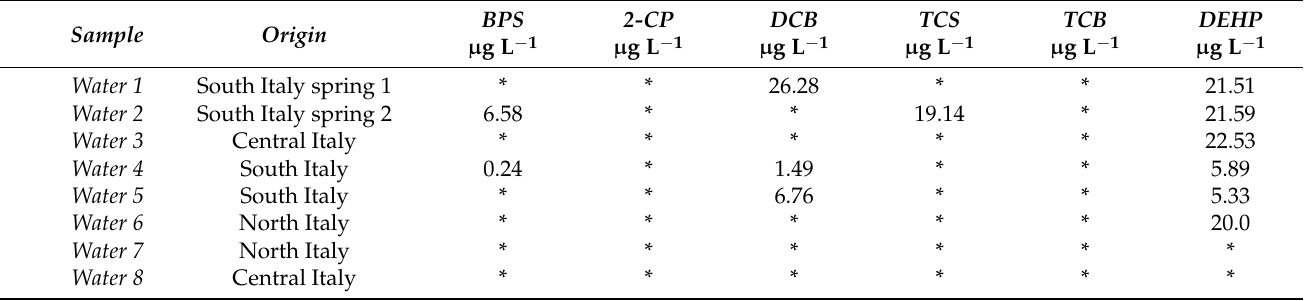
Table 2. UV detected chemicals under